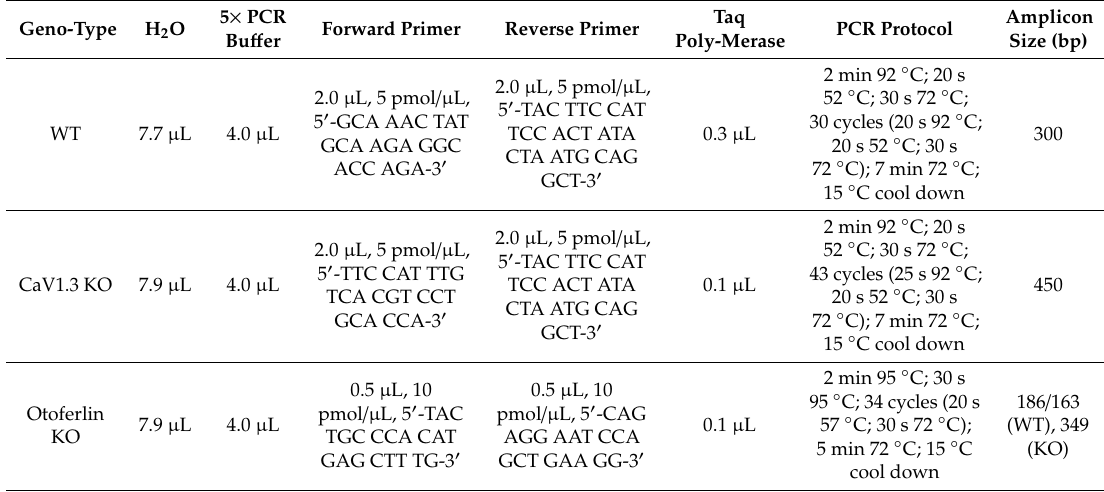
Table 1. Master mixes for PCR solutions and protocols used for genotyping of WT and KO